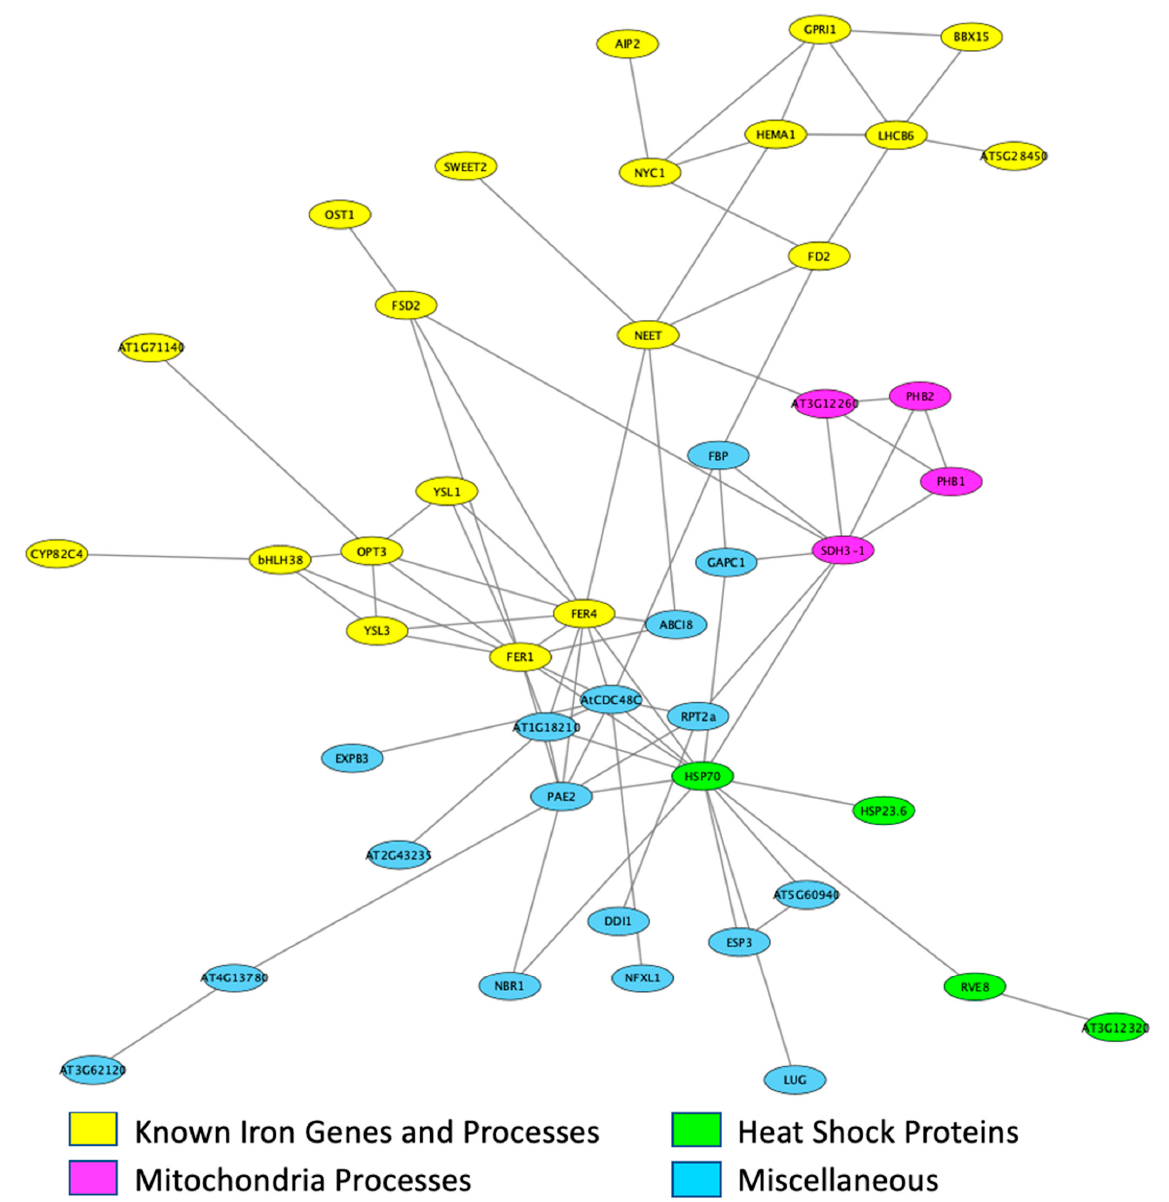
Figure 5. STRING network for DEGs identified between FeS and FeD in Mandarin (Ottawa) leaves. The 152 DEGs identified in Mandarin (Ottawa) responding to iron deficiency correspond to 122 genes in Arabidopsis thaliana . Known interactions between the Arabidopsis homologs were identified using the STRING database. Only 44 of the 122 Arabidopsis genes were known to interact in any way. Annotations of Arabidopsis genes were used to assign biological functions to the genes, these are denoted in the legend.